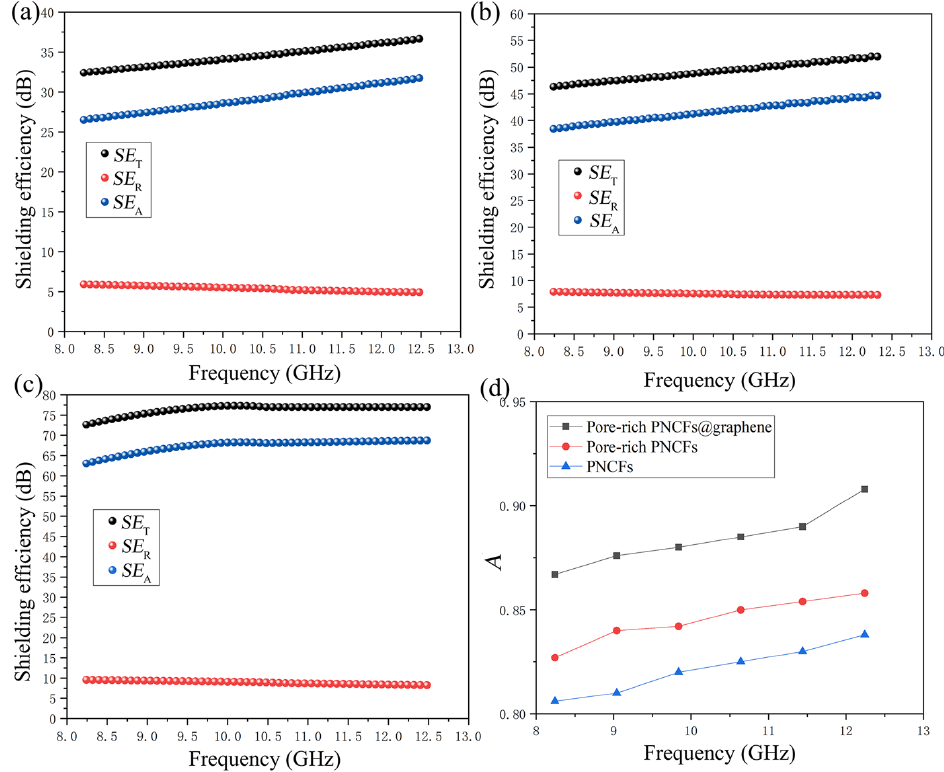
Figure 7. SE T , SE A, and SE T values of the ( a ) PNCFs, ( b ) pore-rich PNCFs, and ( c ) pore-rich PNCFs@graphene, respectively; ( d ) the A value of X-band PNCFs, pore-rich PNCFs and pore-rich PNCFs@graphene.